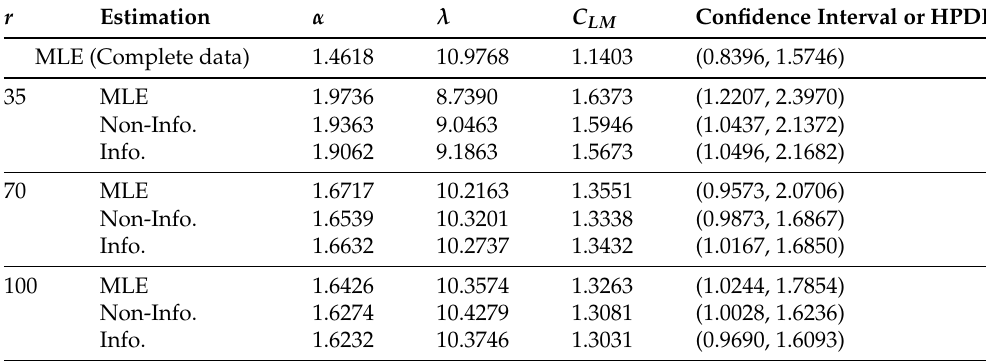
Table 6. The estimation results of Example 2 ( n = 100 waiting times and T = 11 in